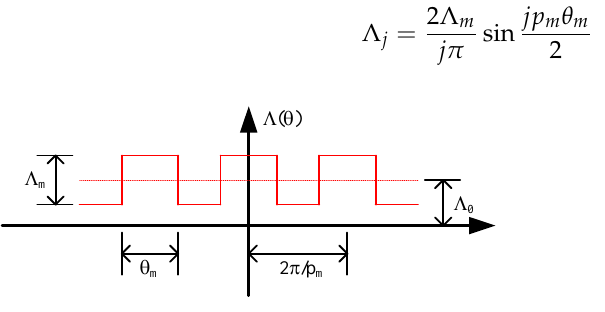
Figure 5. Permeance waveform of the modulator.